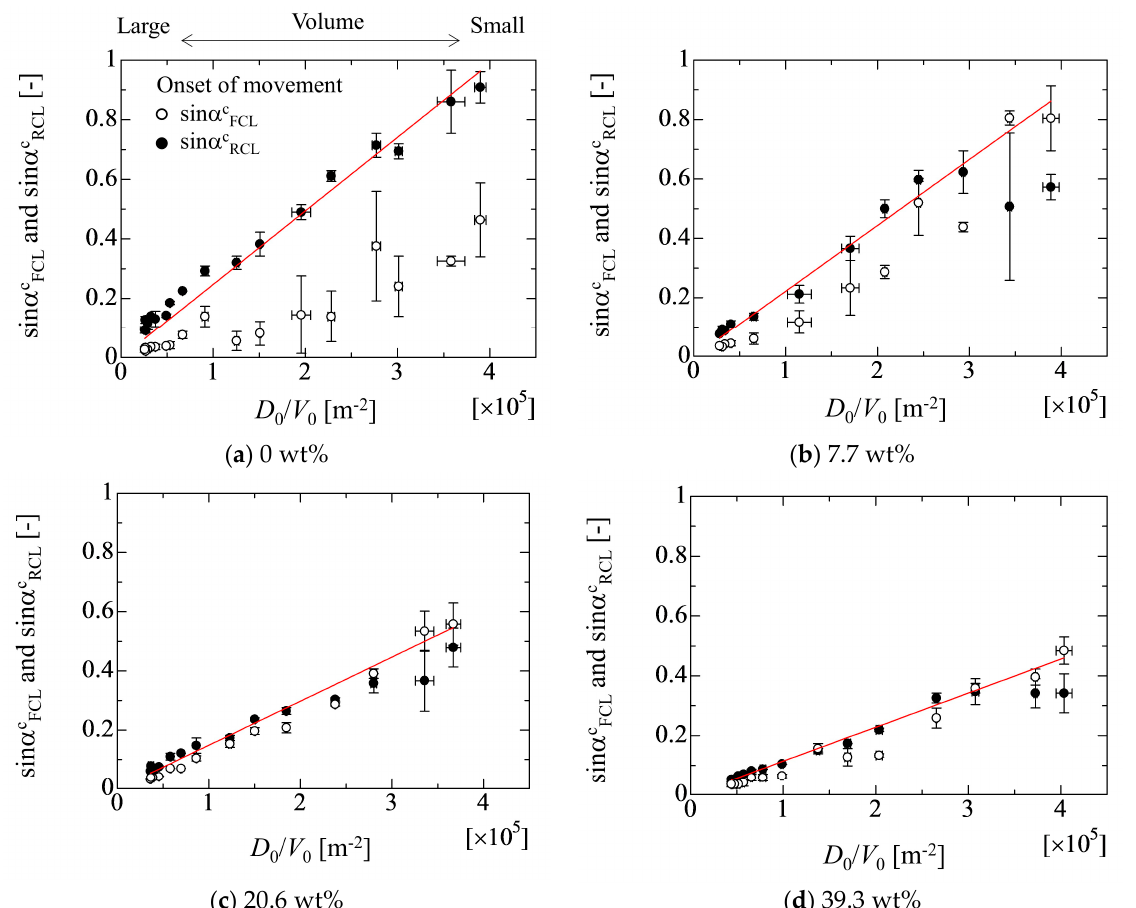
Figure 8. Relationship between critical inclined angles of sin α cFCL and sin α cRCL and D 0 / V 0 in each liquid property.